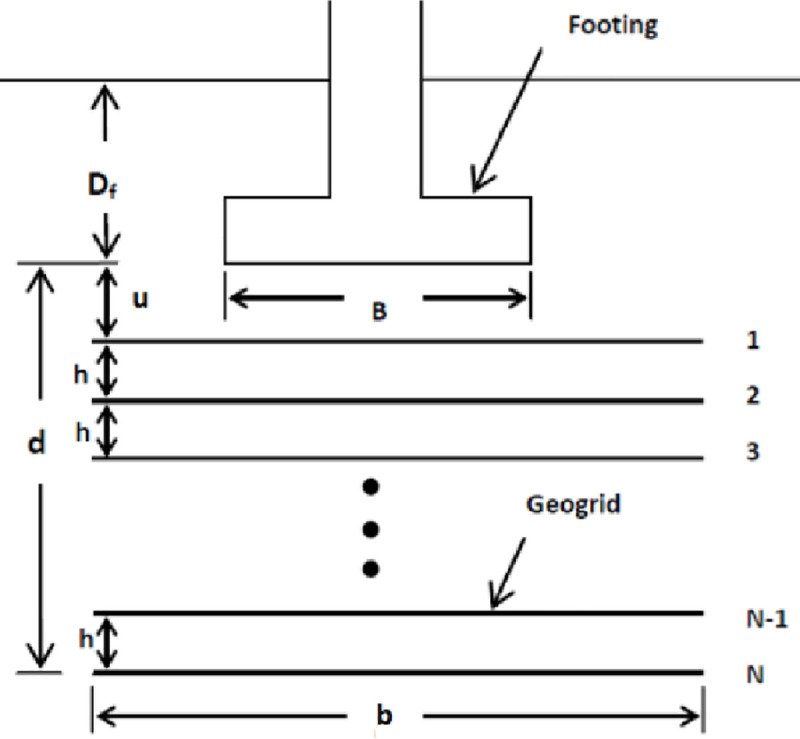
Geogrid reinforced soil foundation [32].